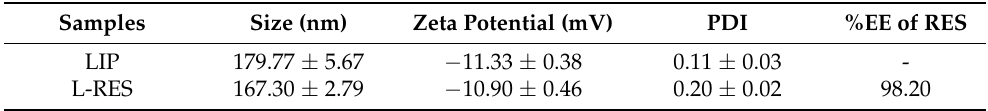
Table 1. Physicochemical properties of resveratrol loaded liposome liposomes. The hydrodynamic size, polydispersity index (PDI), and zeta potential of liposomes were measured by the dynamic light scattering. Encapsulation efficiency was determined using